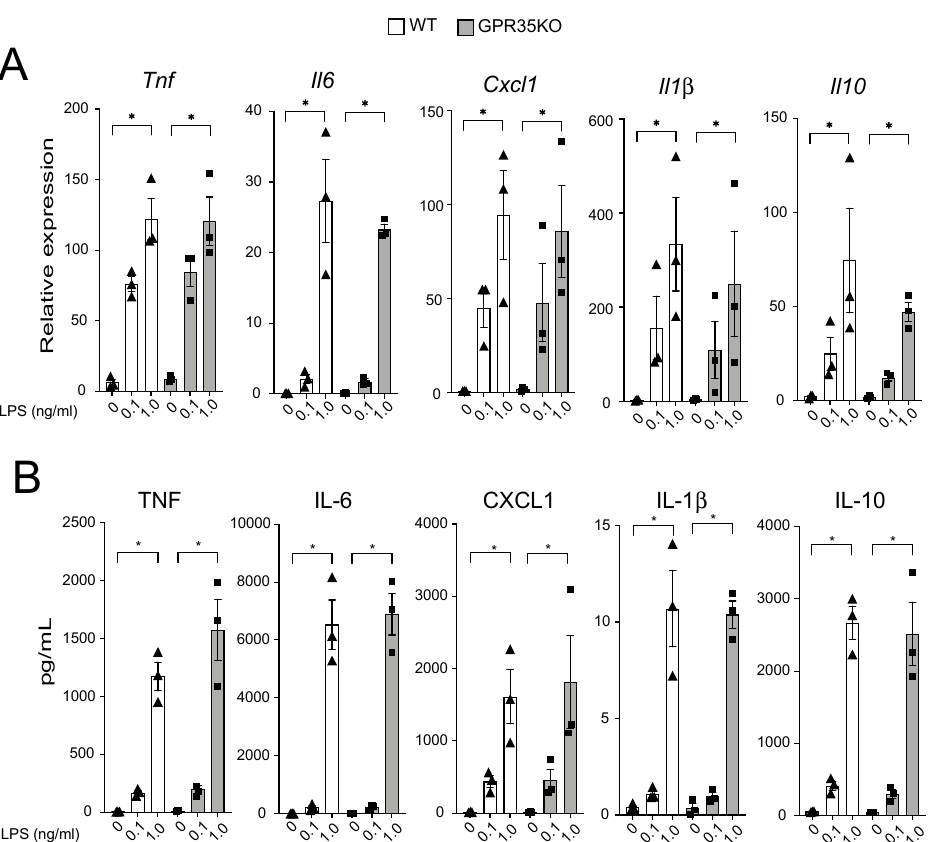
Figure 4. Dose-dependent response of GPR35KO and WT BMDMs to LPS. ( A ) Relative mRNA expression of Tnf, Il6, Cxcl1, Il1 β , and Il10 on BMDMs from GPR35KO and WT mice, after 2 h incubation with increasing doses of LPS; n = cells from 3 mice/ group. ( B ) Levels of TNF, IL-6, CXCL1, IL-1 β , and IL-10 secreted by BMDMs from GPR35KO and WT mice, after 20 h incubation with increasing doses of LPS; n = cells from 3 mice/ group. Results are mean ± SEM. Friedman test with Dunn’s post-test was used for the pairwise comparisons. (*) p < 0.05.